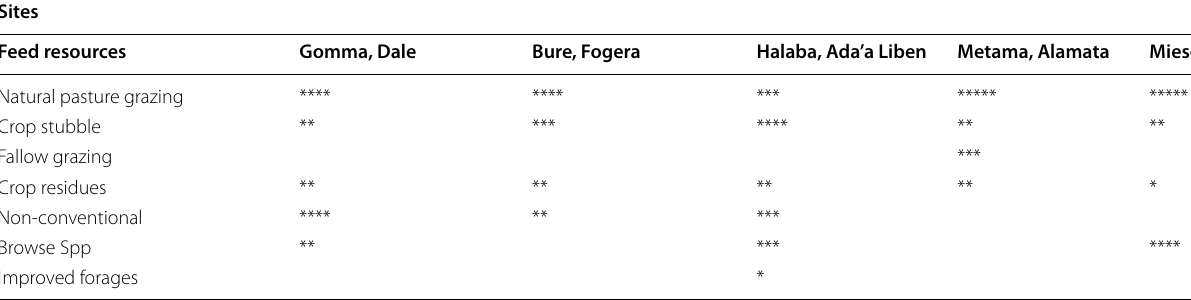
The number of asterisks (*’s) denotes the important feed resource based on the percentage of farmers who selected feed resources as crucial in boosting goat production